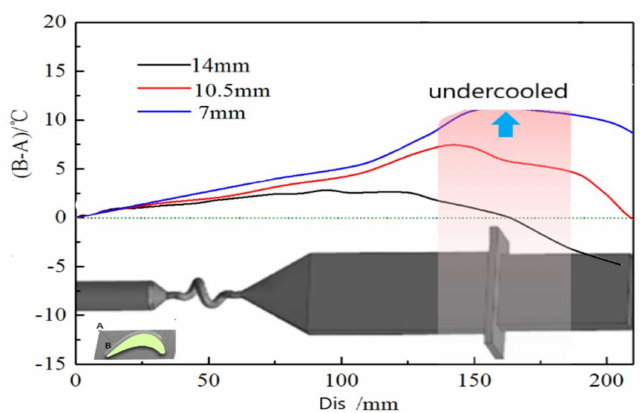
Figure 8. Temperature difference of B–A